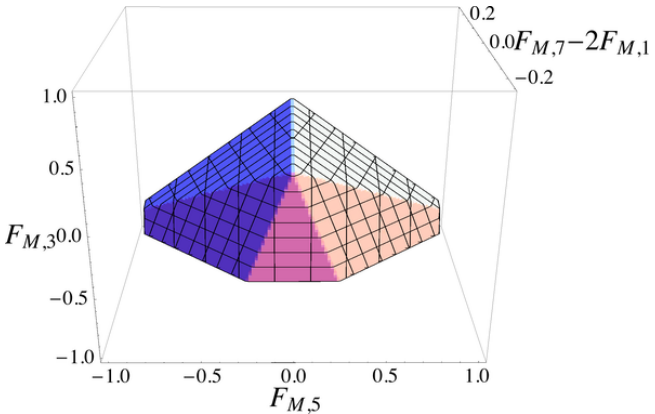
Figure 13 . Positivity bound described by M M , the linear conditions in the M